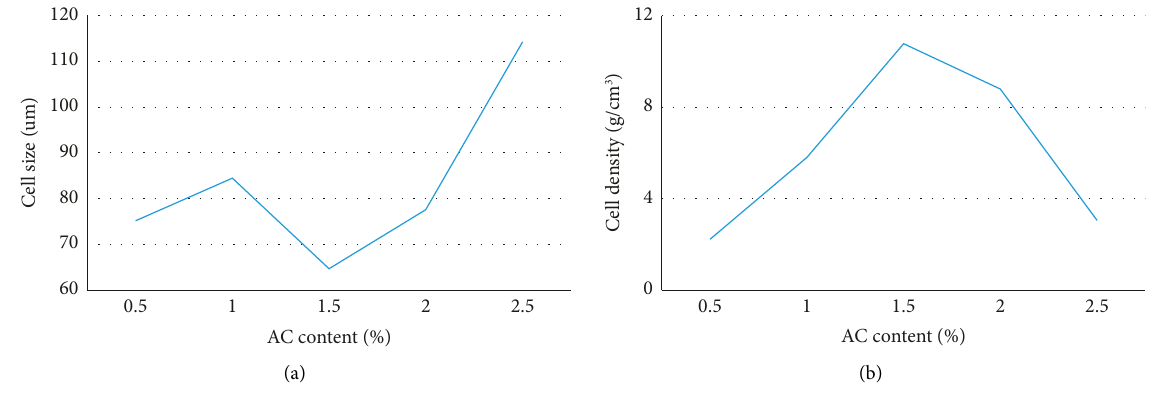
Figure 8: Graph of cell size and cell density of foamed samples under different AC contents. (a) The effect of different AC content on the cell size of the sample. (b) The effect of different AC content on the cell density of the sample.